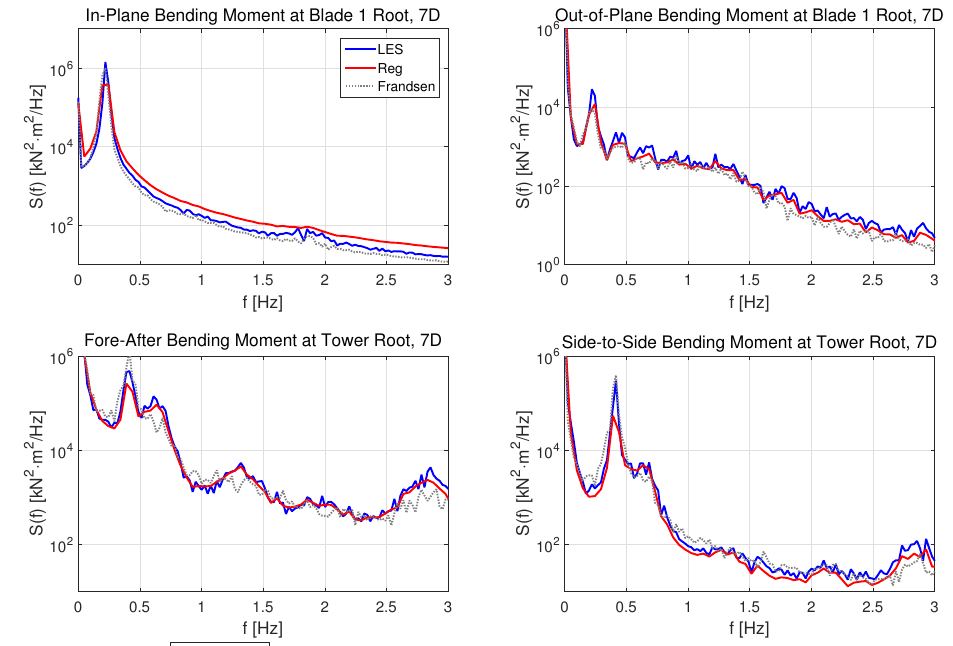
Figure 32. Power spectra of turbine loads in the wake at x = 7 D based on LES and the stochastic